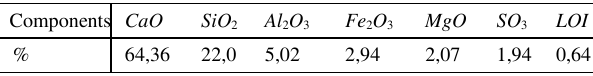
Table 1. Chemical composition of the